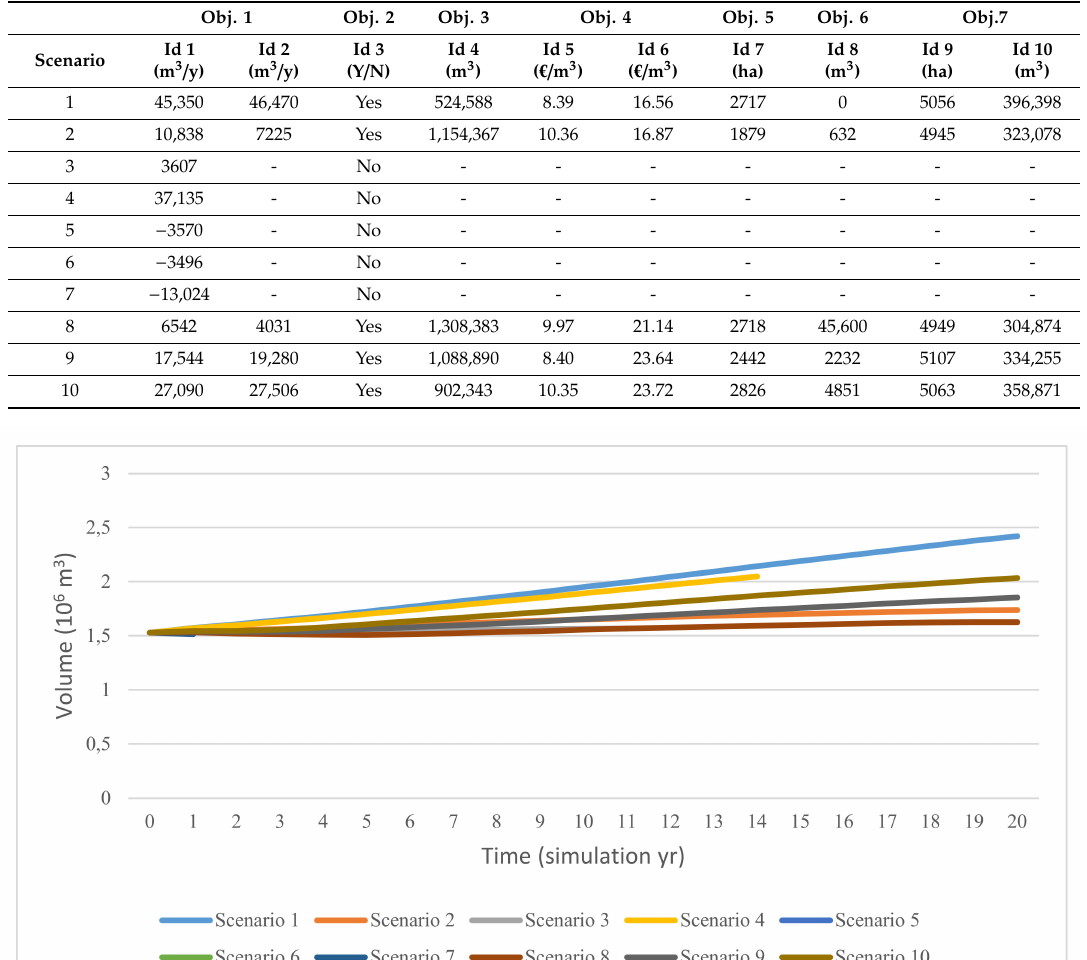
Table 5. Forest biomass assessment indicators outputs for the second simulation using adjusted volume goals (minimum and maximum) in each industry / scenario (Table A5, Appendix C). All values are averages of 5 simulations (FD1 to FD5).